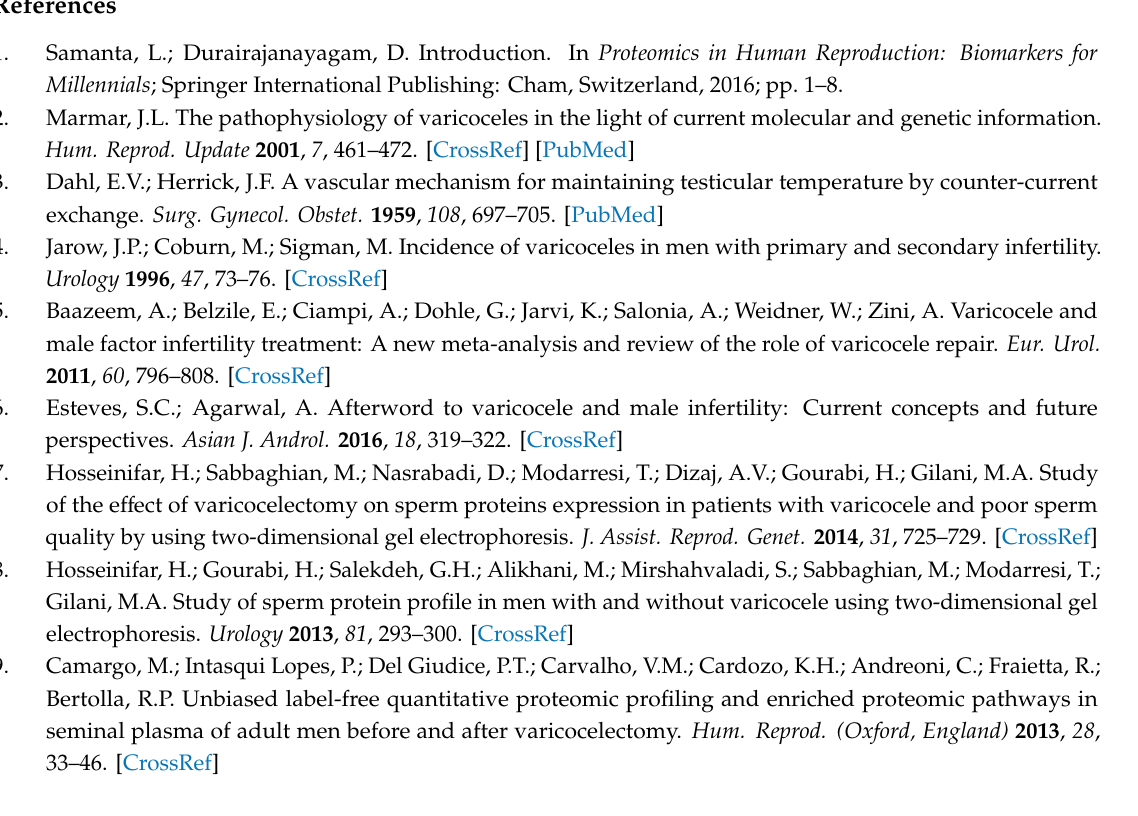
Supplementary Table S1. Semen parameters in infertile men with unilateral and bilateral varicocele. Supplementary Table S2. List of proteins involved in the acetylation process in the spermatozoa of unilateral and bilateral varicocele infertile